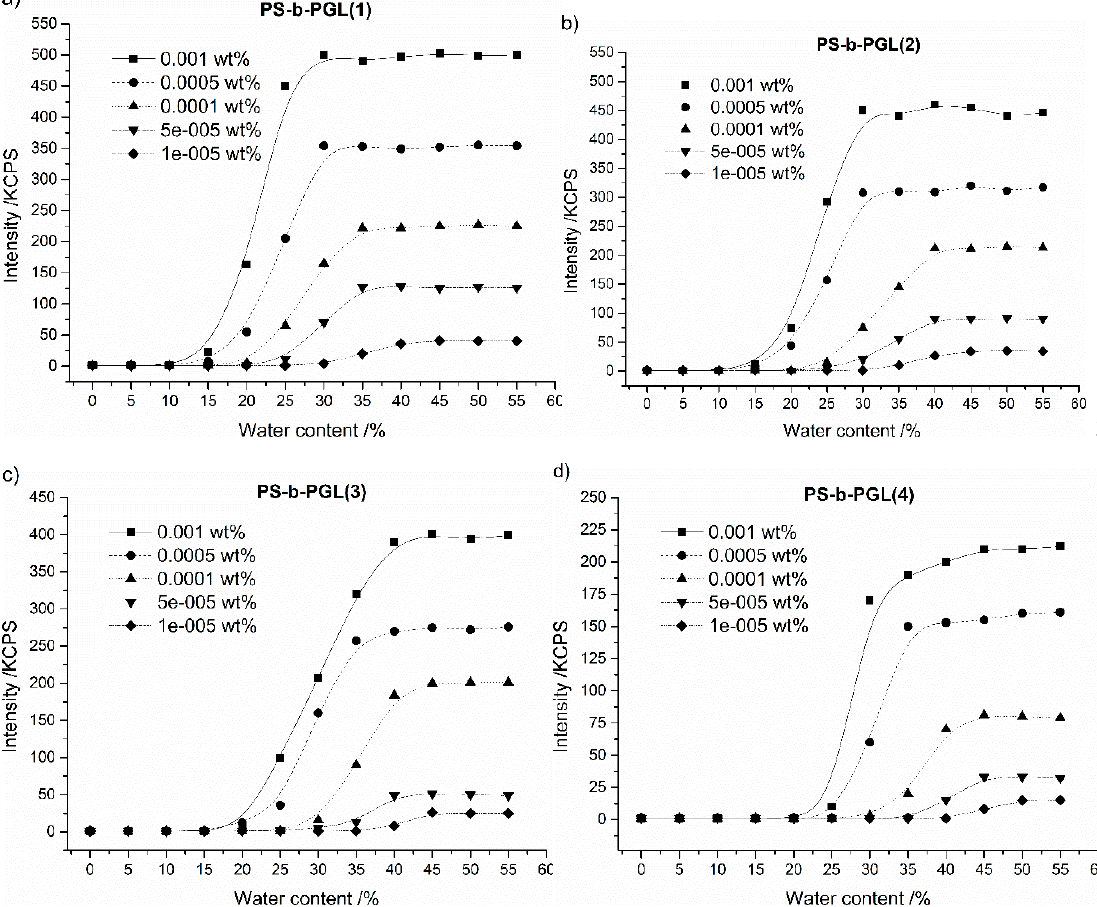
Figure 3. The scattered light intensity as a function of water content in the dioxane solution with various initial copolymer ( a ) PS- b -PGL(1), ( b ) PS- b -PGL(2), ( c ) PS- b -PGL(3), ( d ) PS- b -PGL(4) concentrations .